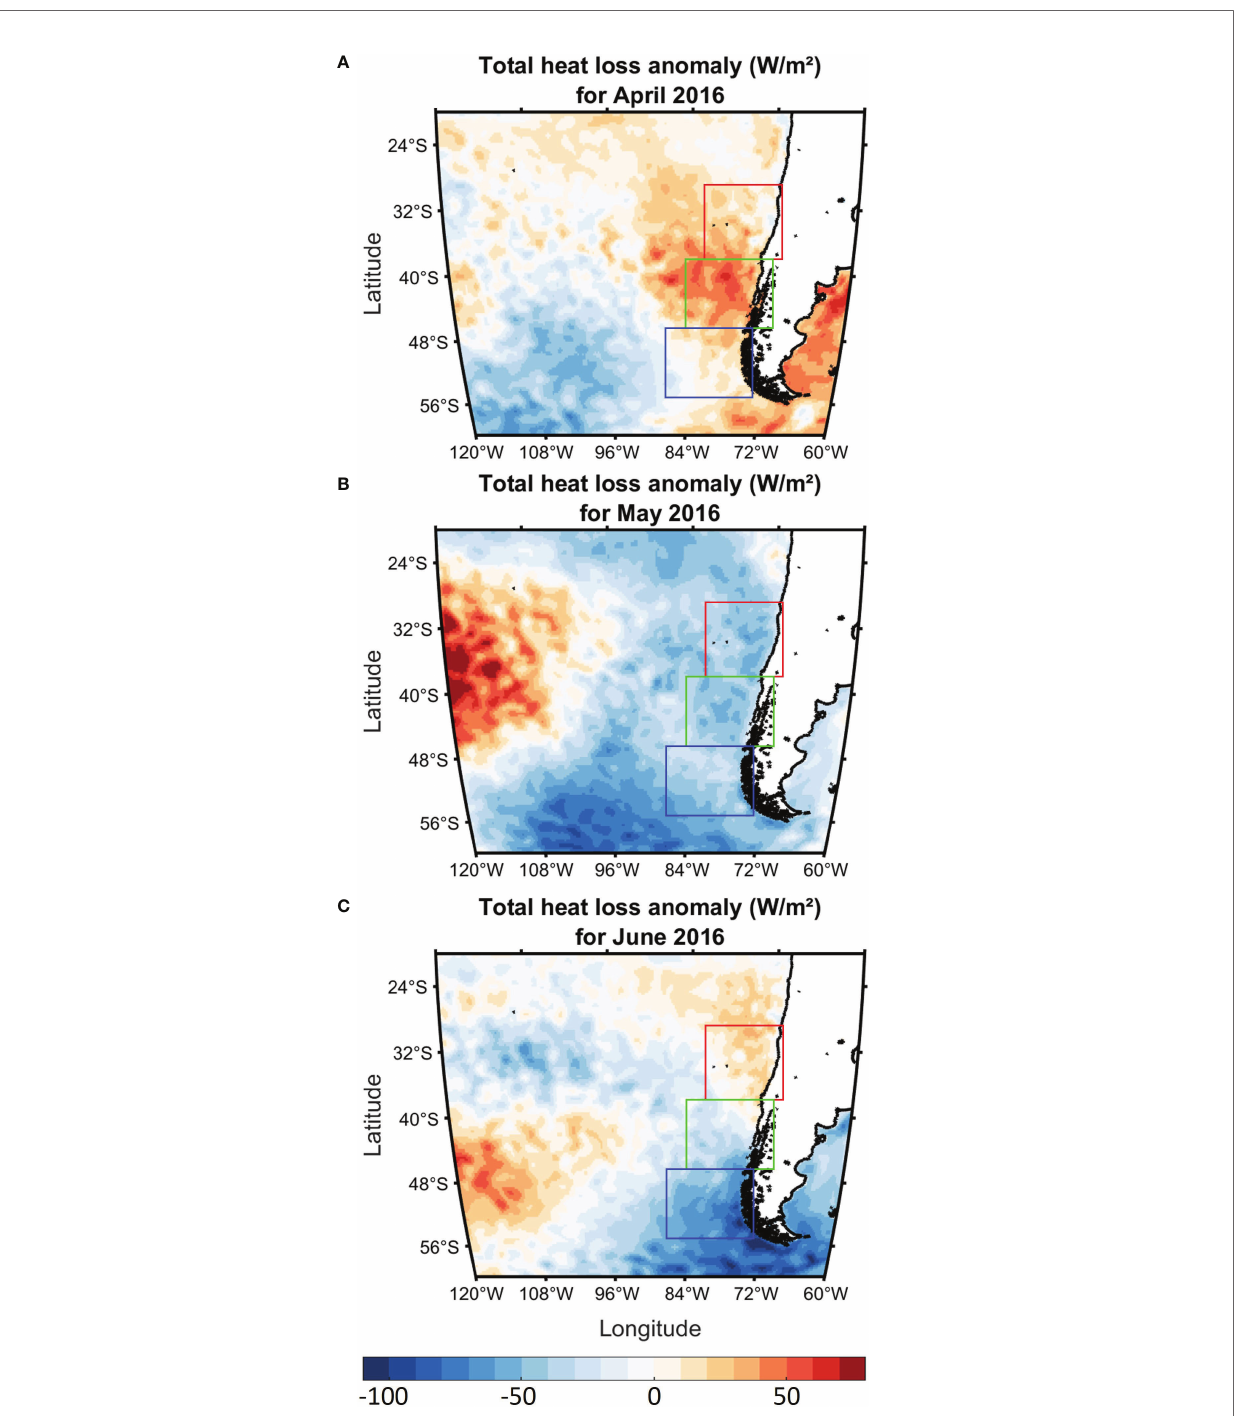
FIGURE 9 | Monthly anomaly of total heat transfer (in W/m²) from the ocean to the atmosphere for (A) April, (B) May, and (C) June of 2016. The anomaly has been calculated according to the 2012 to 2020